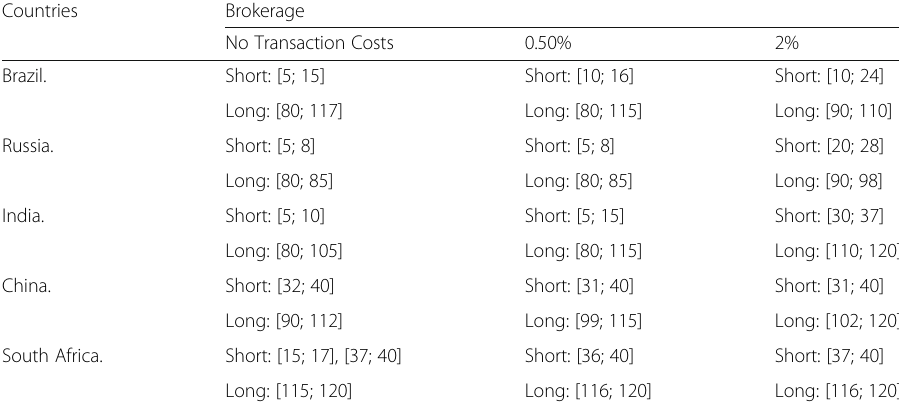
Table 5 Best pairs of Moving Averages considering the combination SMA vs SMA Countries Brokerage No Transaction Costs 0.50% 2% Brazil. Russia. India. China. South Africa.